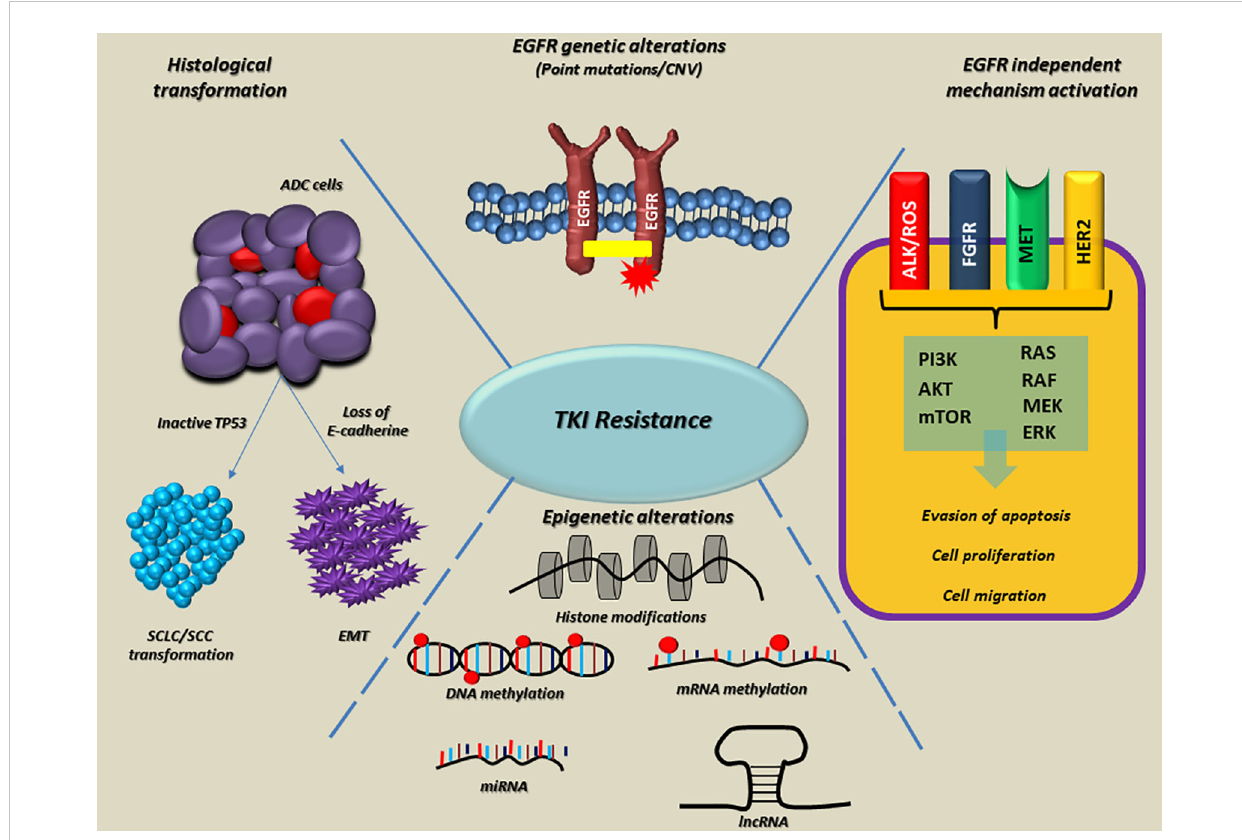
FIGURE 1 Overview of the main molecular mechanisms linked to EGFR-TKI resistance in NSCLC. On the top, EGFR alterations, as point mutations and copy number variations (CNVs) are involved both in intrinsic and acquired resistance to TKI. On the right side, the EGFR-independent mechanisms bypass RTK signaling through ALK, ROS, FGFR, MET, HER2 alterations onset, thus promoting the activation of alternative and downstream pathways (e.g., PI3K/AKT/mTOR and RAS/RAF/MEK/ERK). At the bottom, epigenetic alterations such as histone modi fi cations, DNA and RNA hypo/hypermethylation, aberrant expression of miRNAs and lncRNA frequently occur in several genes, which are able to promote tumor progression, metastasis and resistance to TKIs. Finally, on the left side, histological modi fi cations such as SCLC or SCC transformation and EMT lead to the loss of sensitivity to EGFR TKIs in lung tumors. The dotted blue lines indicate interconnections among mechanisms linked to the EGFR-TKI resistance. EGFR, epidermal growth factor receptor; TKI, Tyrosine kinase inhibitors; Ex, exon; ins, insertion; amp, ampli fi cation; RTK, receptor tyrosine kinase; ALK, Anaplastic lymphoma kinase; ROS, ROS Proto-Oncogene, Receptor Tyrosine Kinase; FGFR, fi broblast growth factor receptor; MET, hepatocyte growth factor receptor; HER2, human epidermal growth factor receptor 2; PI3K, Phosphoinositide 3-kinase; AKT, Protein kinase B; mTOR, mammalian target of rapamycin; RAS, rat sarcoma virus; RAF, proto-oncogene c-RAF; MEK, Mitogen-activated protein kinase kinase; ERK, Extracellular signal-regulated kinase; miRNA, microRNA; lncRNA, long non-coding RNA; SCLC, small cell lung cancer; SCC, squamous cell carcinoma; EMT, epithelial − mesenchymal transition; ADC, adenocarcinoma; TP53, Tumor protein